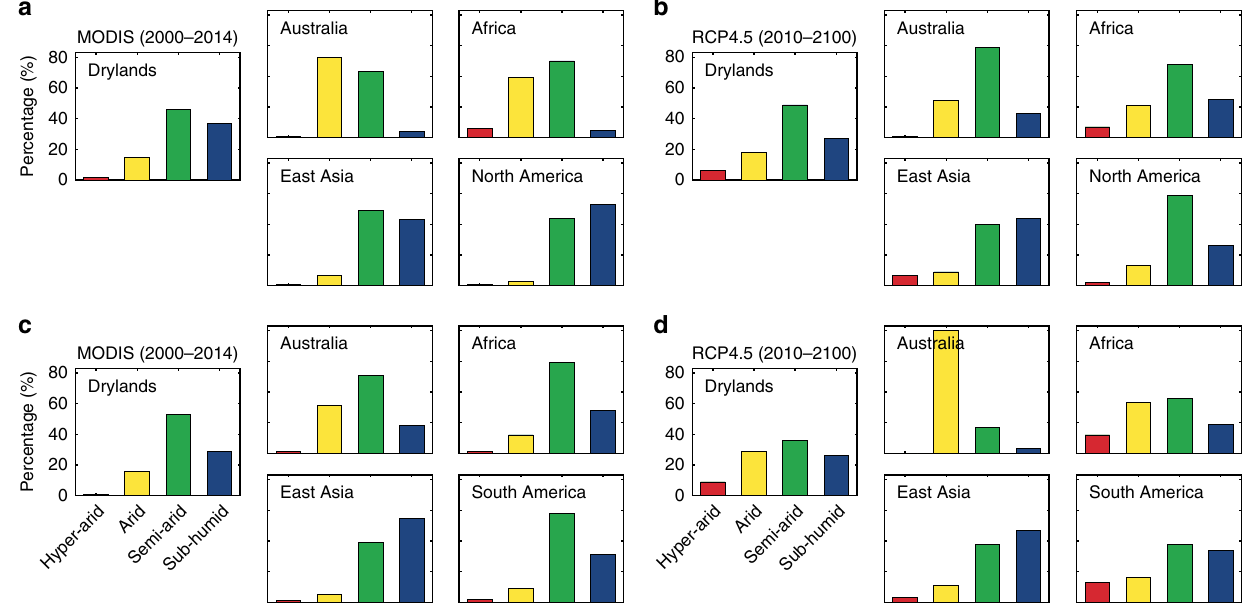
Fig. 3 Contributions from the four subtypes to global dryland GPP. a , b Gross primary production (GPP) trend and c , d interannual variability (IAV) in 2000 – 2014 (MODIS) and 2011 – 2100 (RCP4.5).